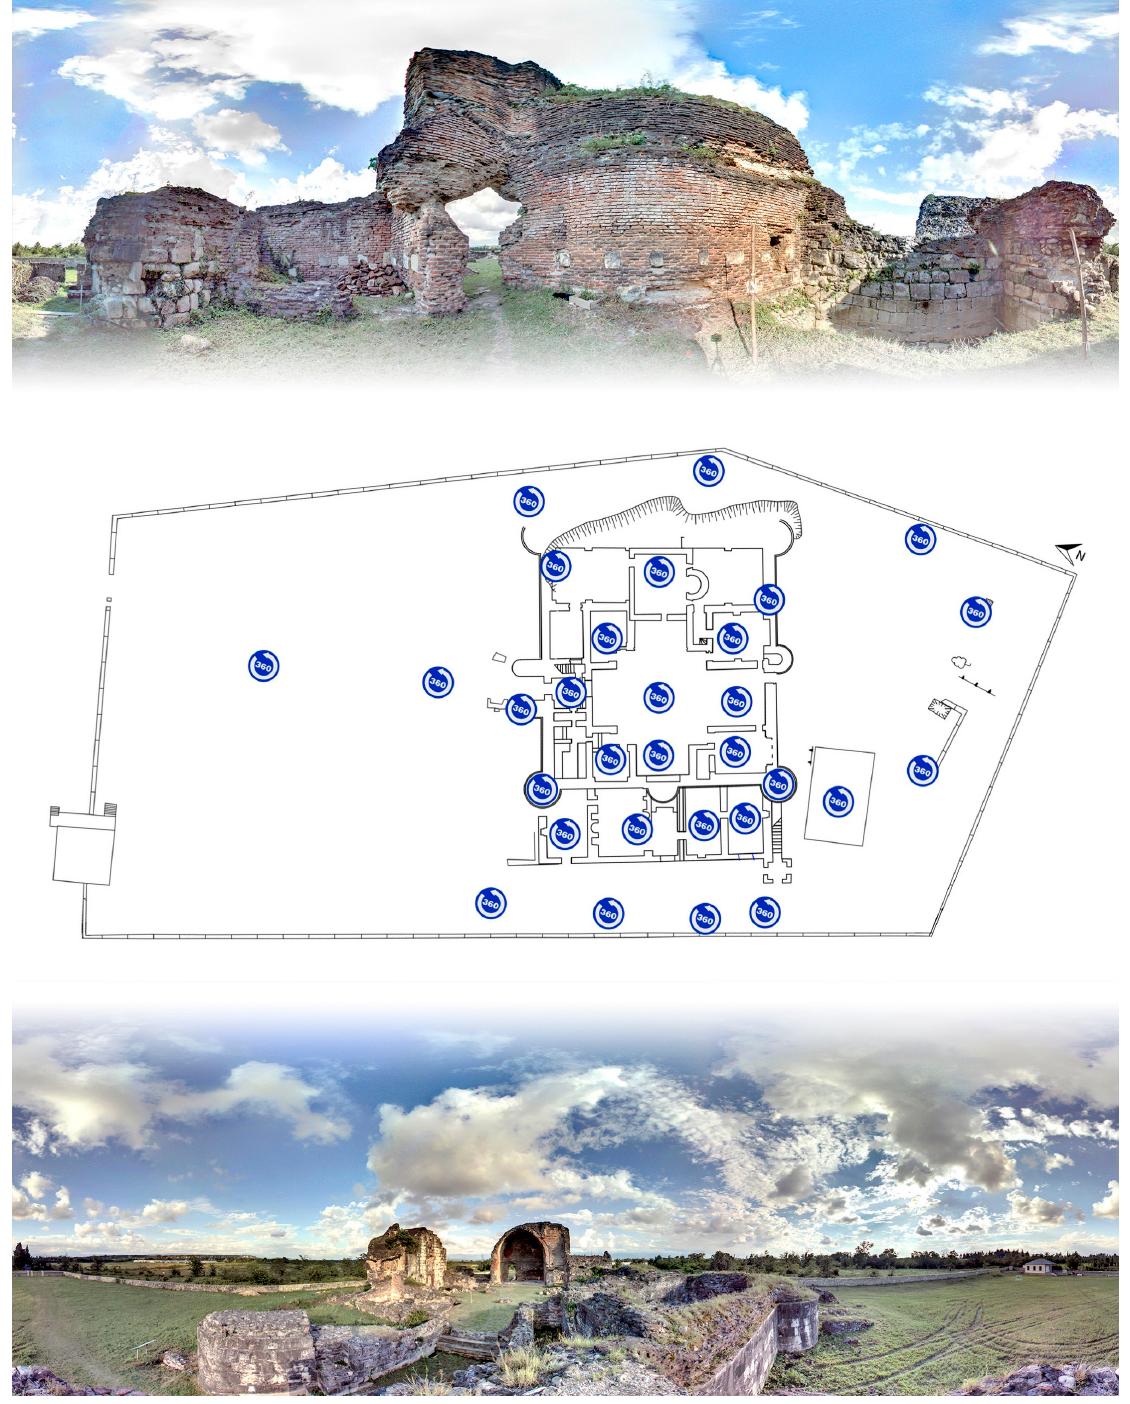
Figure 2. During summer 2016, 30 HDR 360° spherical photos have been taken in order to develop an exhaustive visualization for VR (Virtual Reality)